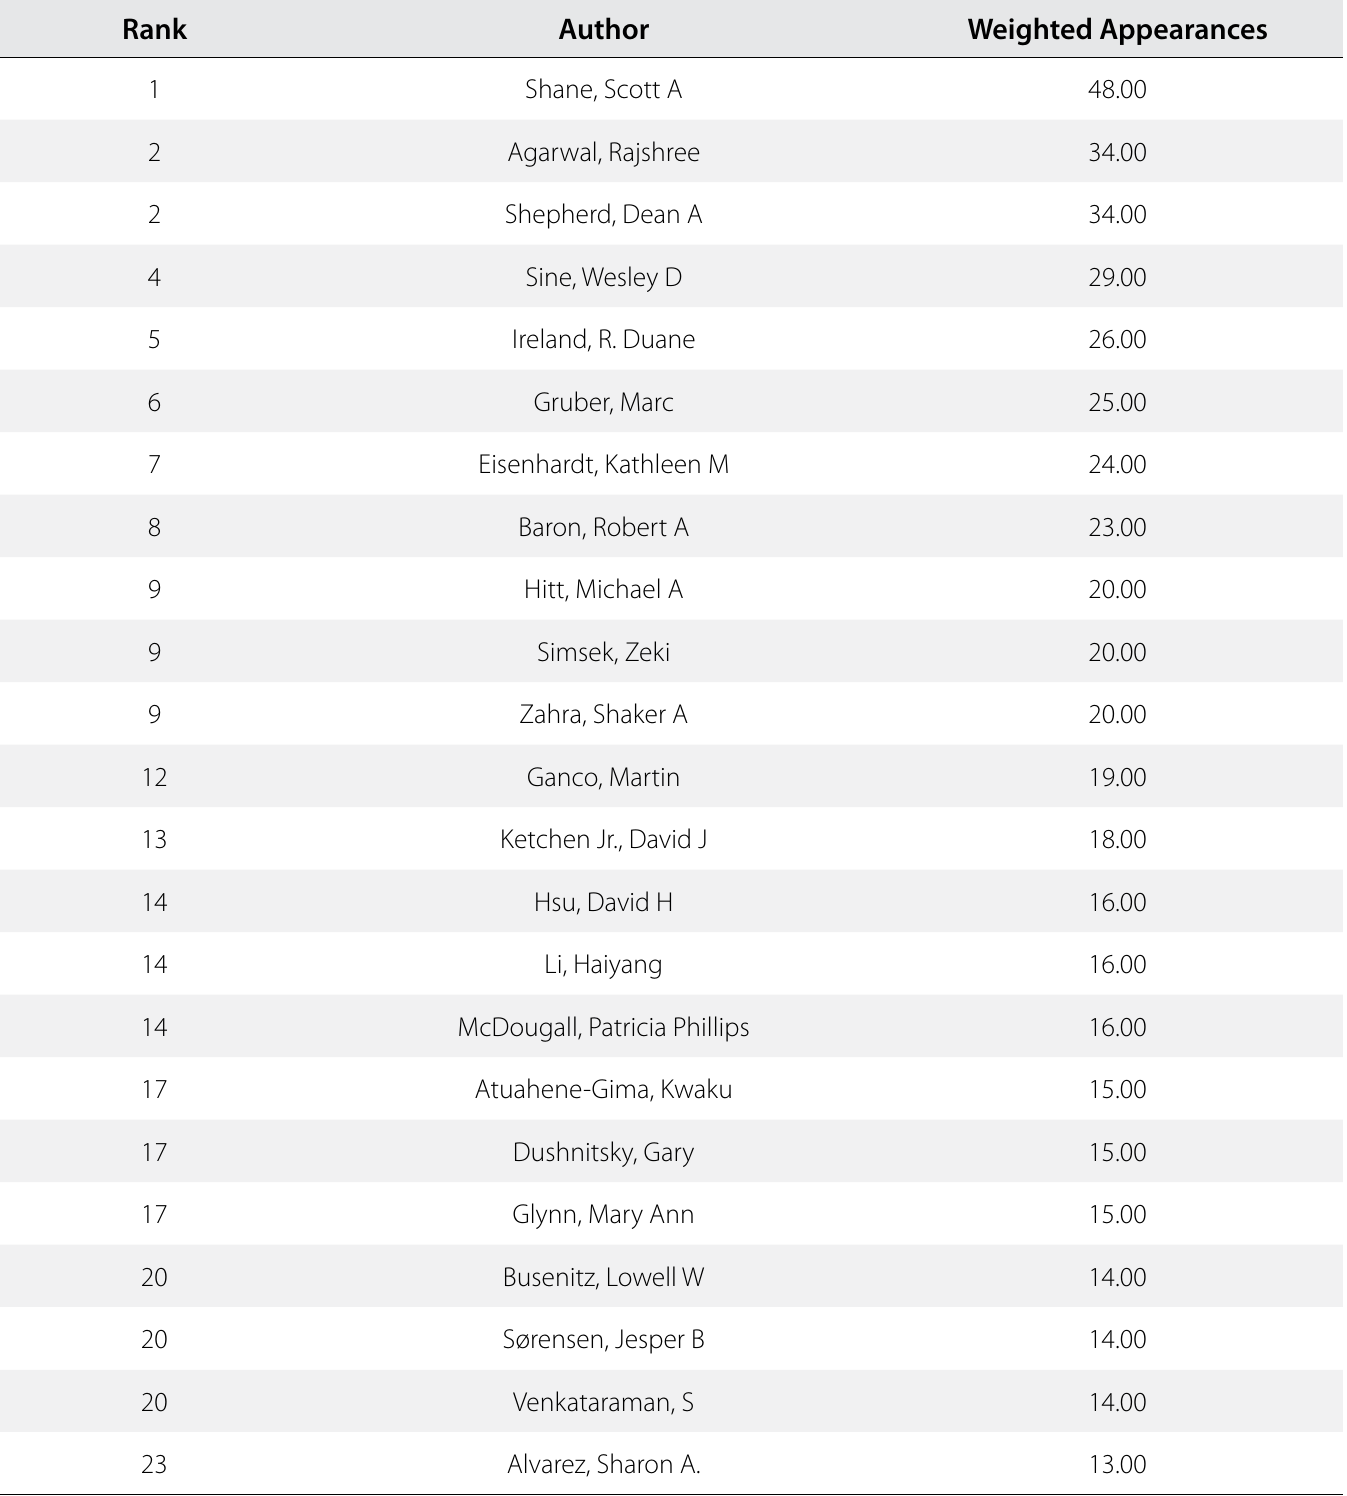
Table 5. Top Authors Ranked by Weighted Appearances